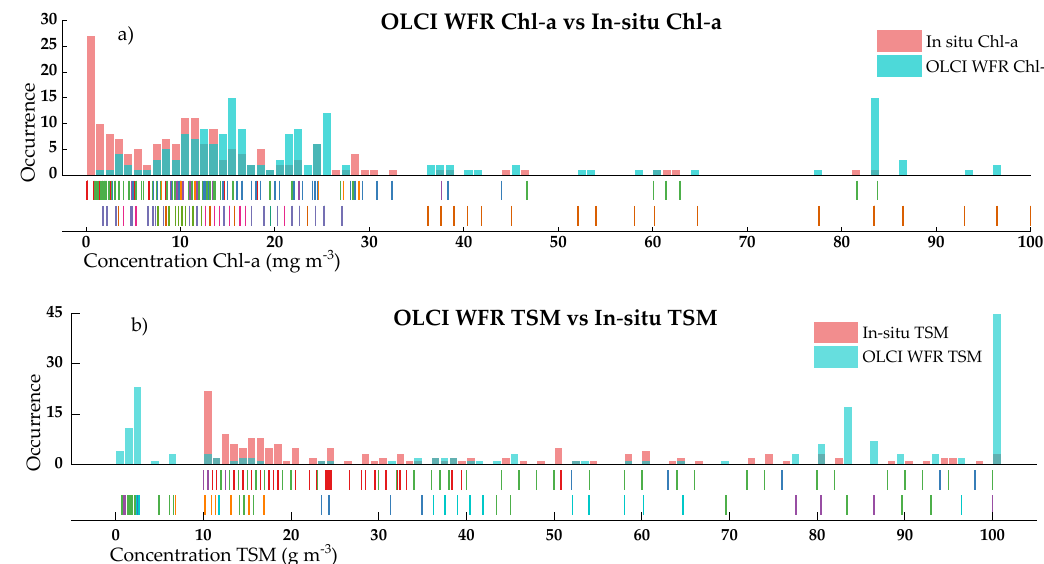
Figure 3. Histograms of OLCI WFR Chl-a ( a ) and TSM ( b ) estimations overlapped to RNMCA measurements. Marks along the x-axis as perpendicular rugs display single qualitative data and its distribution.